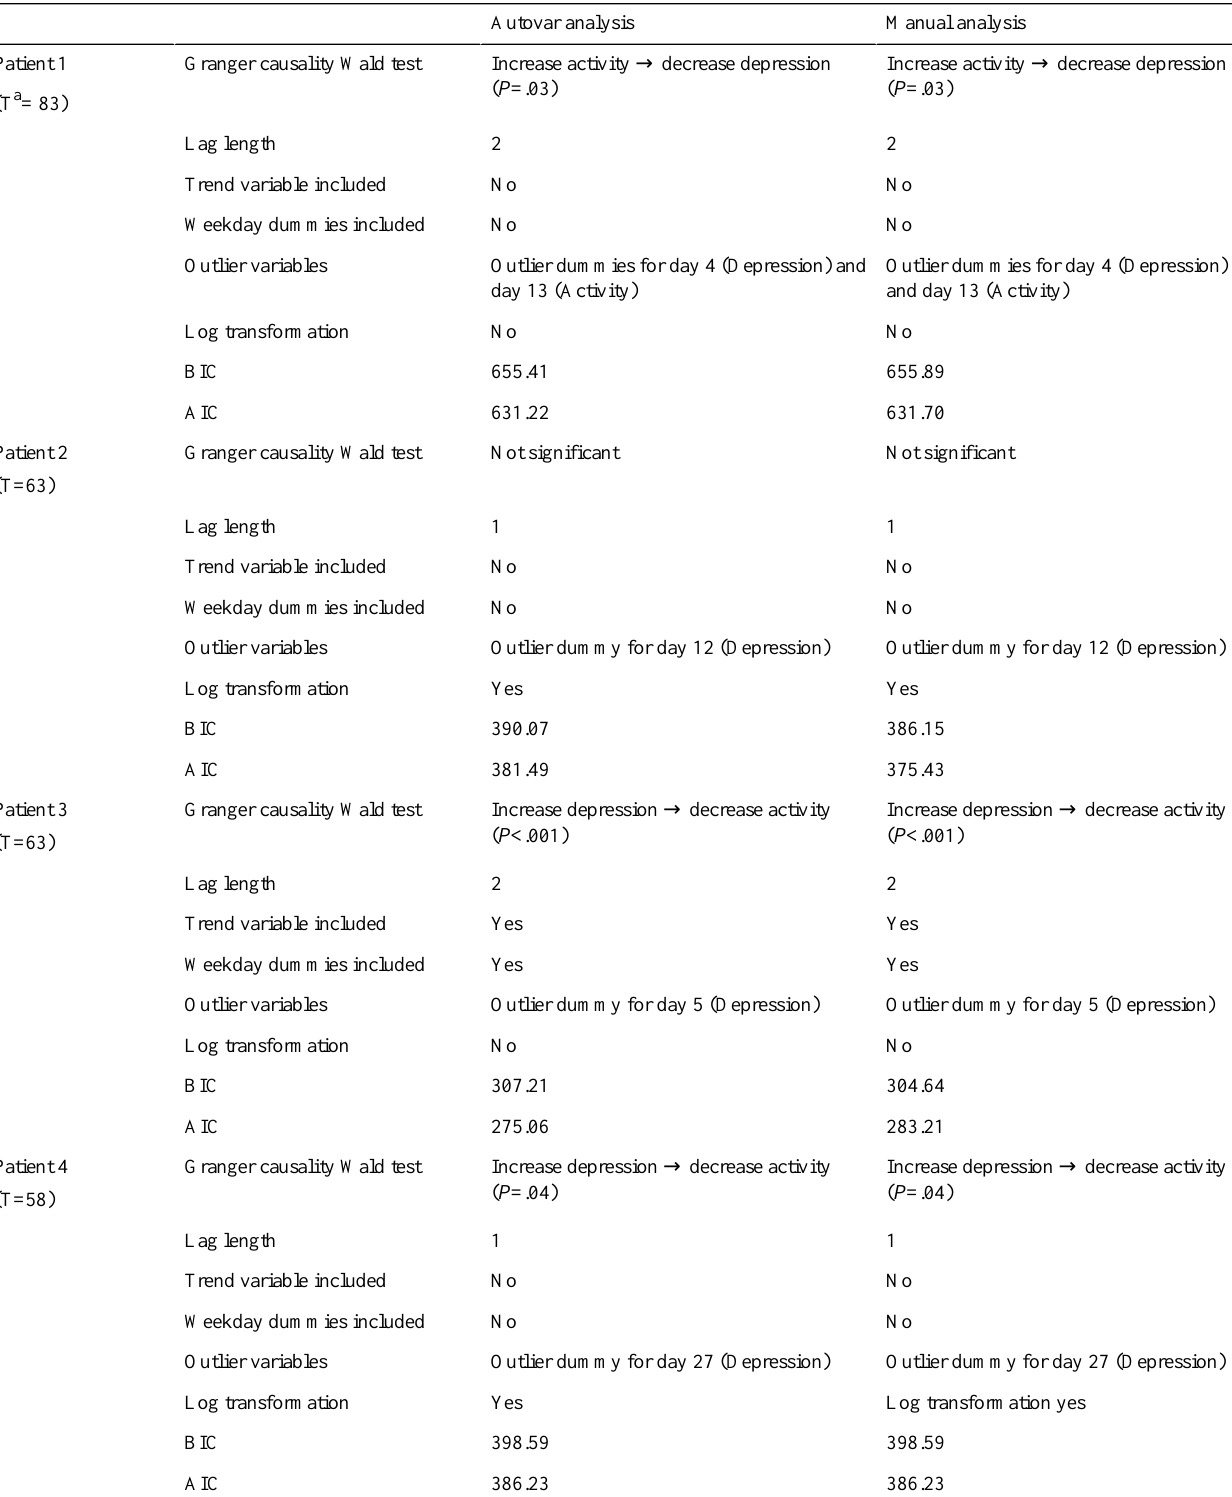
Table 1. Comparison of AutoVAR output versus manual analysis output.